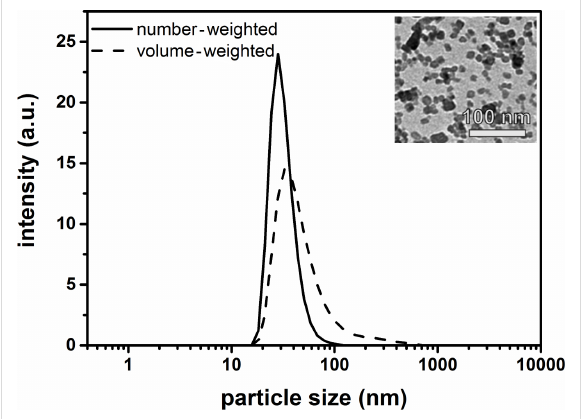
Figure 1: DLS measurement of the CaF 2 :(Tb 3+ ,Gd 3+ ) NPs (number- and volume-weighted). Inset: TEM micrograph of the same particles. The size of the NPs is in the range of 5–10 nm and they have a spheri- cal shape.